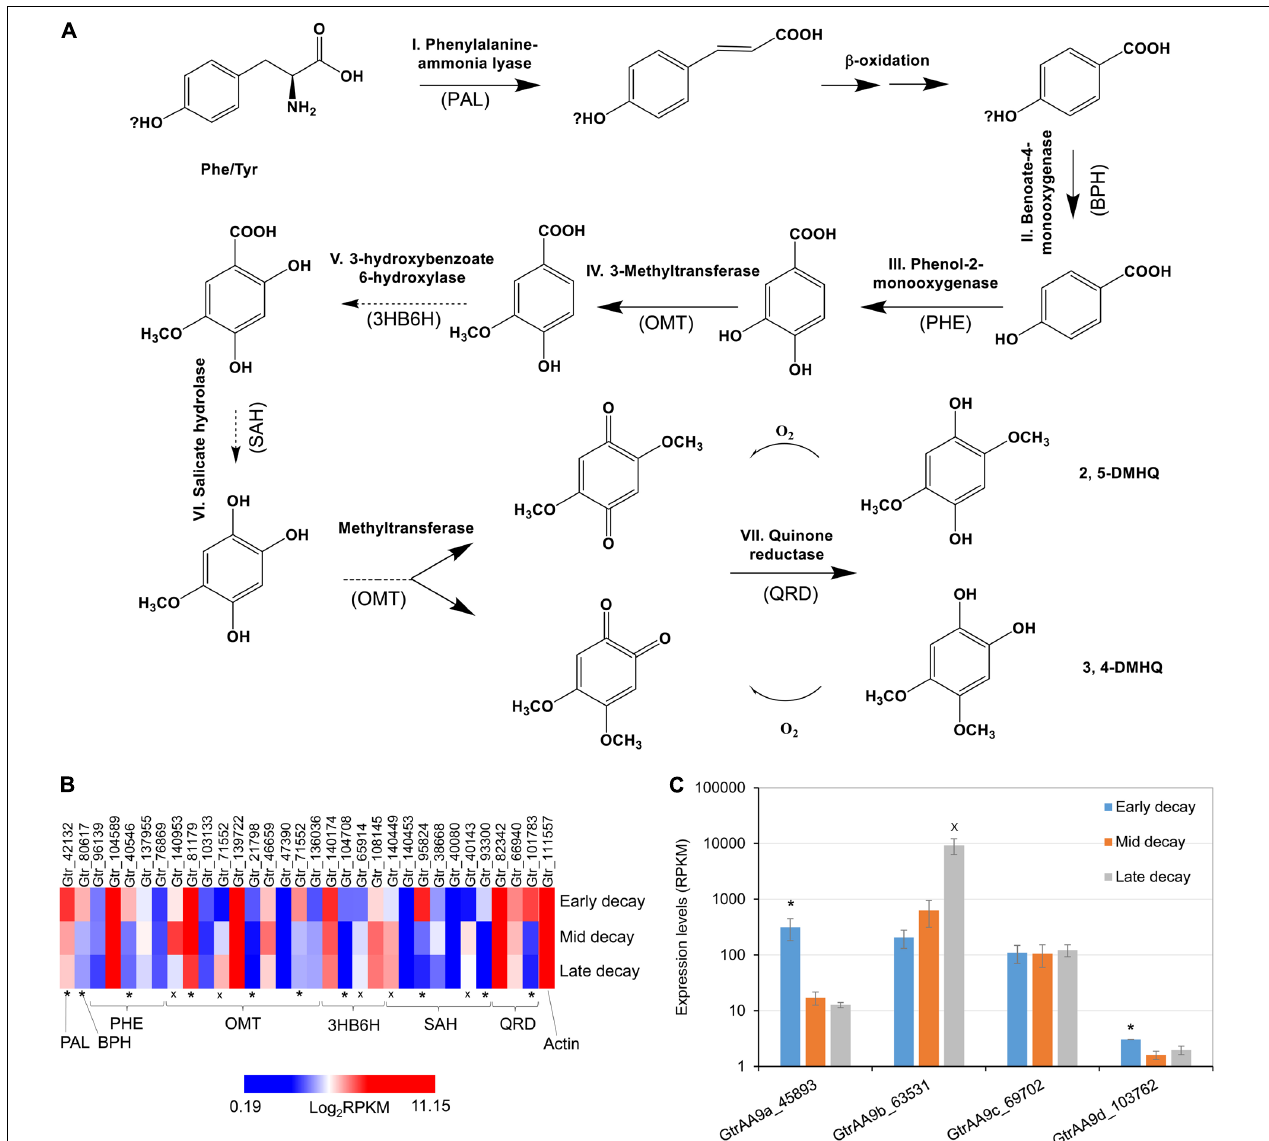
FIGURE 4 | Co-expression of LPMO and LMW hydroquinone pathways at an early brown rot stage in G. trabeum . (A) The hydroquinone chelator synthesis pathway and the enzyme homologs catalyzing each step are proposed based on standard pathways. Genes that were significantly upregulated (*, FDR < 0.05 by RNA-seq) in early brown rot basically covered all the required key enzyme components of the pathway, although several OMT, 3HB6H and SAH genes were clearly upregulated at late decay stages (x, FDR < 0.05) (B) . Expression timing of G. trabeum LPMO genes showed that AA9a was significantly upregulated in early brown rot stages, and these were co-expressed with genes for metabolites produced in proposed pathway for hydroquinone synthesis. (C) Expression levels for GtrAA9 genes during early-, mid- and late-decay